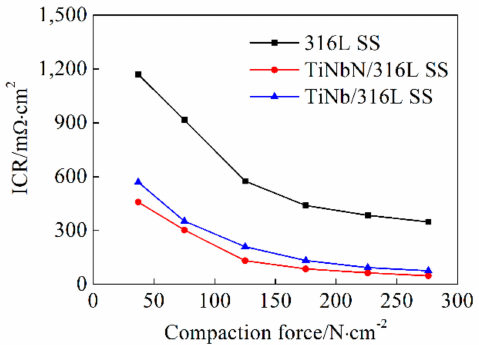
Figure 10. Interfacial contact resistances (ICR) between 316L SS, TiNb / 316L SS, TiNbN / 316L SS and carbon paper as a function of compaction